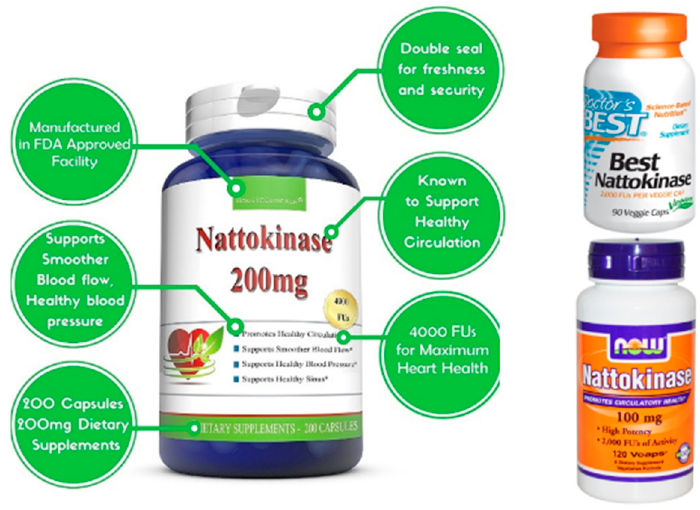
Figure 4. Nattokinase products (Pictures obtained from company websites).